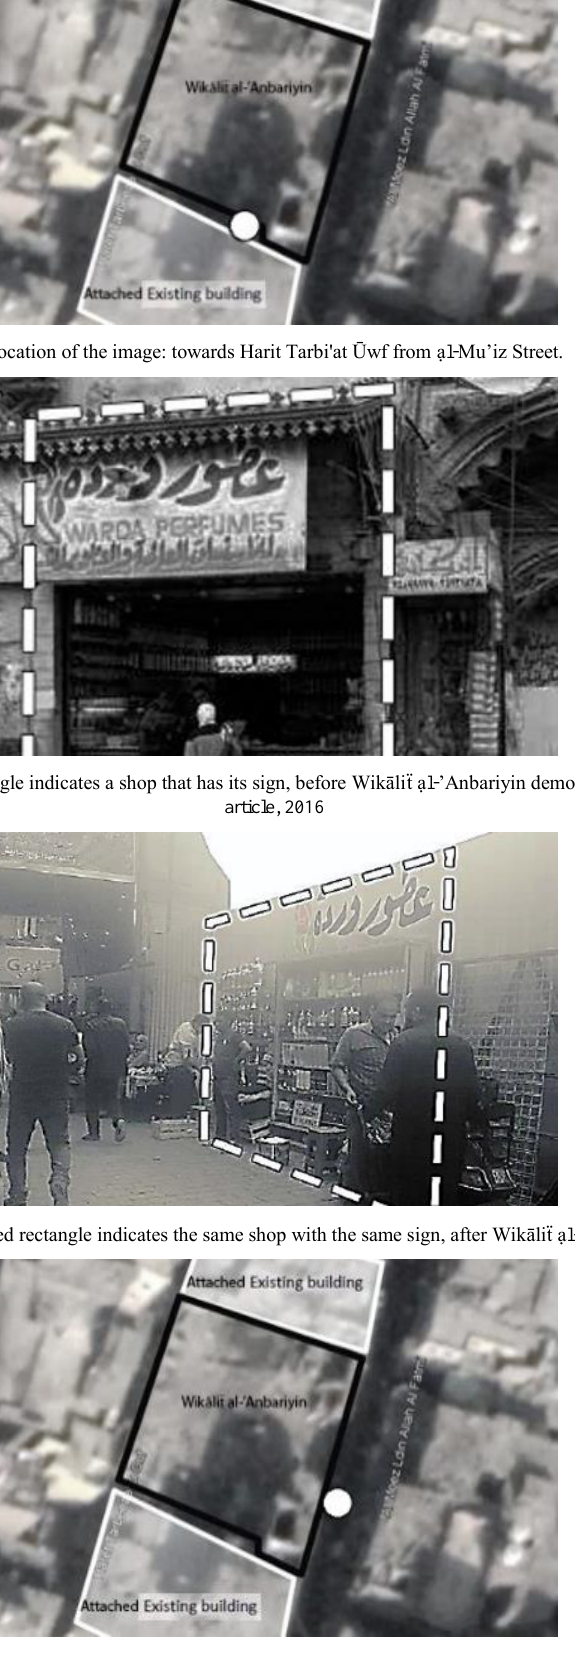
Location of the image: ạl-Mu’iz